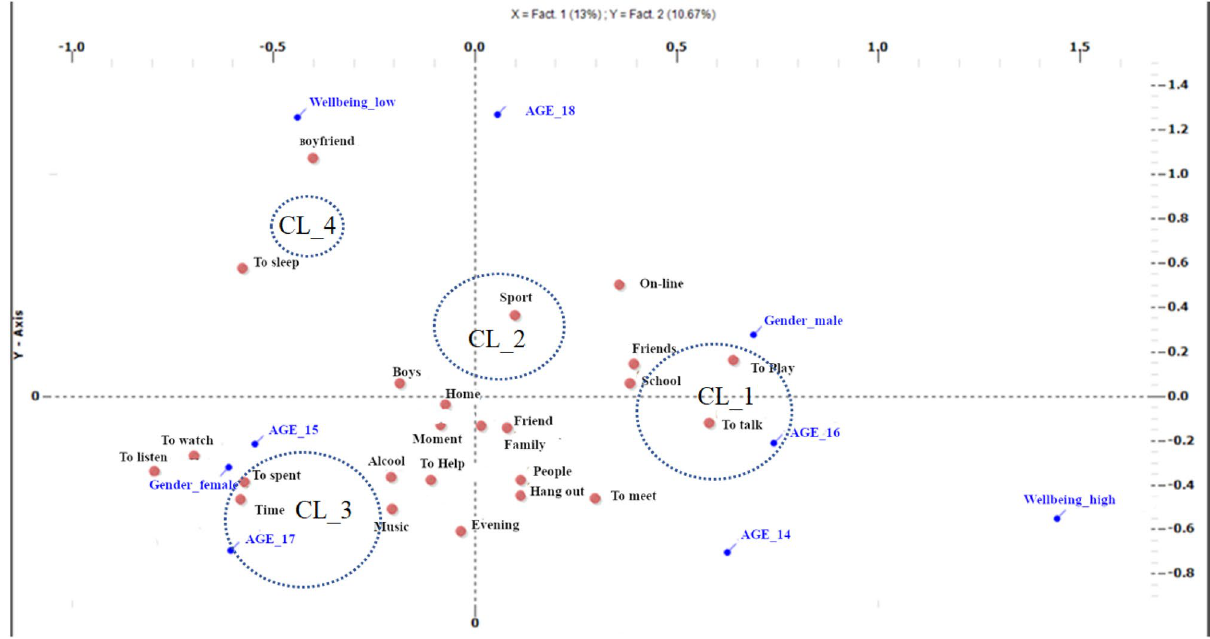
Figure 2. Graphical representation of clusters and occurrences in a Cartesian